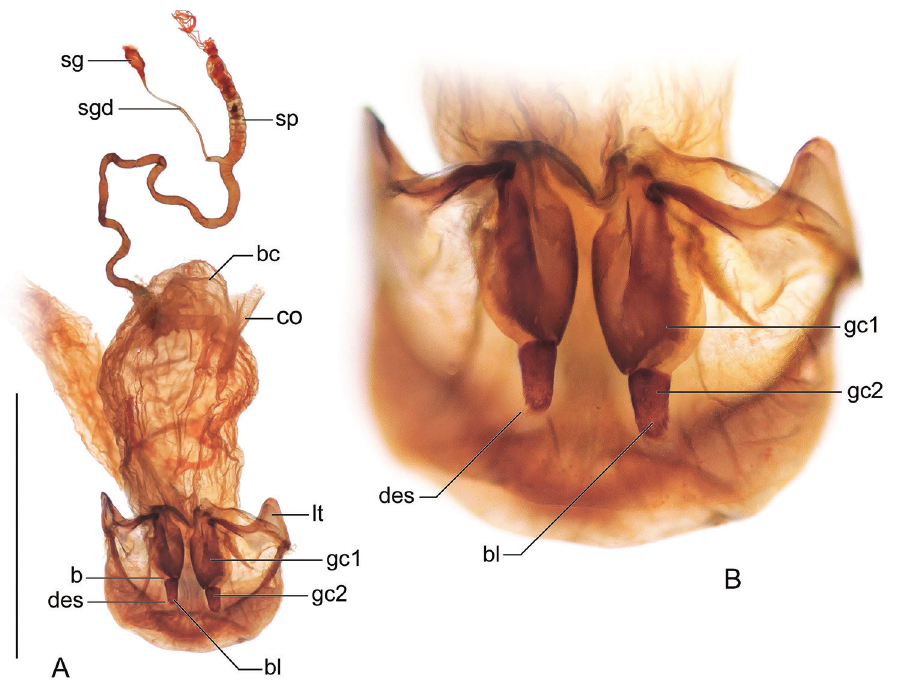
Figure 8. Digital Photo-illustration, female reproductive system dorsal and ventral aspects. Hyboptera lucida Henry & Erwin sp. n., ADP148100. Legend, bc, bursa copulatrix; sg, spermathecal gland; sgd, spermathecal gland duct; sp, spermatheca. Dorsal aspect; lt, laterotergite; gc1, gonocoxite 1; gc2, gono- coxite 2, des, dorsal ensiform seta, b, base of gonocoxite 2; bl, blade of gonocoxite 2. Scale line = 0.25